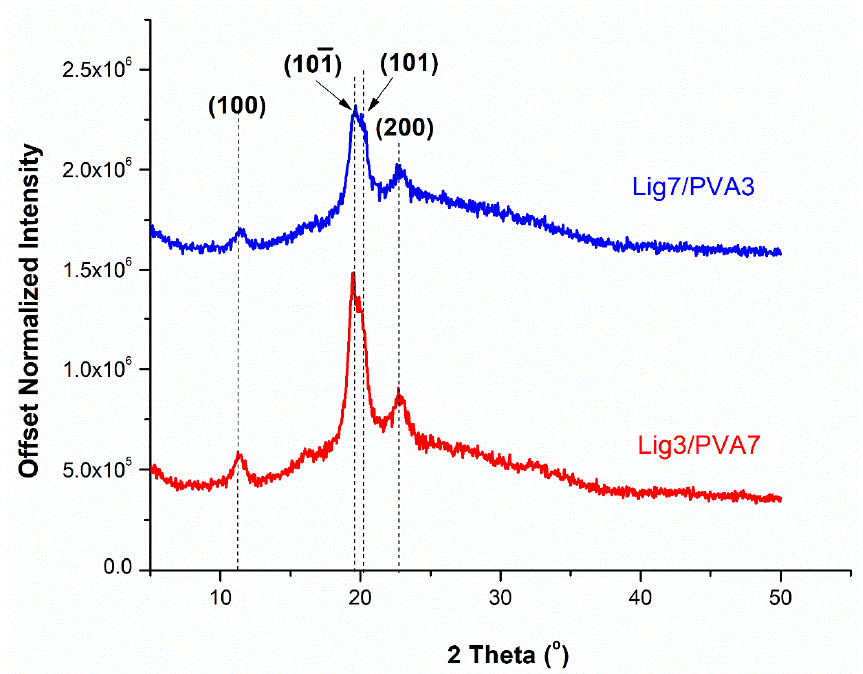
Figure 8. WAXD diffractograms of Lignin/PVA gel fibers. Intermolecular bonding between lignin and PVA induces molecular adhesion. The IR absorbance spectrum from 3000 to 3700 cm − 1 (Figure 9) provides insight into hydrogen bonding for lignin and PVA. Table 3 describes the functional groups characteristic of PVA, lignin, and DMSO as detected by IR spectroscopy. Among lignin/PVA fibers, the absorbance peak of -OH shifted from 3304 cm − 1 (see SI) for neat PVA to 3284 cm − 1 for Lig3/PVA7 fiber (Figure 9). This implies hydrogen bonding between lignin and PVA [6,9,18]. At the highest lignin content (70%), the 3284 cm − 1 peak shifted to 3318 cm − 1 which suggesting less intermolecular interaction than Lig3/PVA7 fibers. Moreover, the -OH stretching vibration for pure PVA (at 3304 cm − 1 ) gradually broadened and weakened, while the C-O stretching vibration at 1087 cm − 1 increased. Strong peaks at 1261 cm − 1 are indicative of C-O stretching in the guaiacylic rings, which are derived from the coniferyl lignin monomer found in both hardwood and softwood sources. Also, characteristic of lignin, strong peaks between 798–810 cm − 1 are indicative of aromatic C-H stretching [1]. The characteristic peak for crystalline conformations of neat PVA (at 1141 cm − 1 ) decreased as the lignin loadings keep increasing from 30–70% [18,19]. Amorphous PVA is associated with the C-O vibrational mode at 1087 cm − 1 and PVA crystallinity affected 1141 cm − 1 absorbance [18,20].